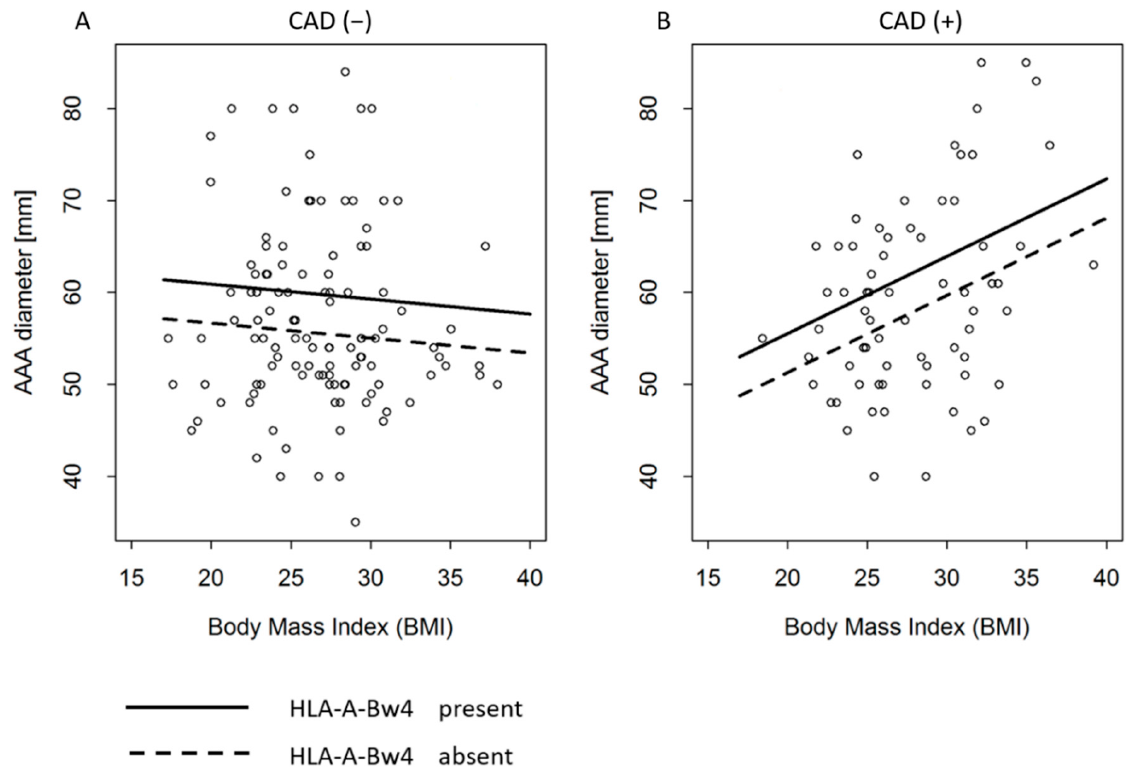
Figure 1. Relation between BMI and AAA diameter, according to CAD and HLA-A-Bw4 presentation ( p = 0.0005). ( A ) AAA patients with no CAD, ( B ) AAA patients with CAD.